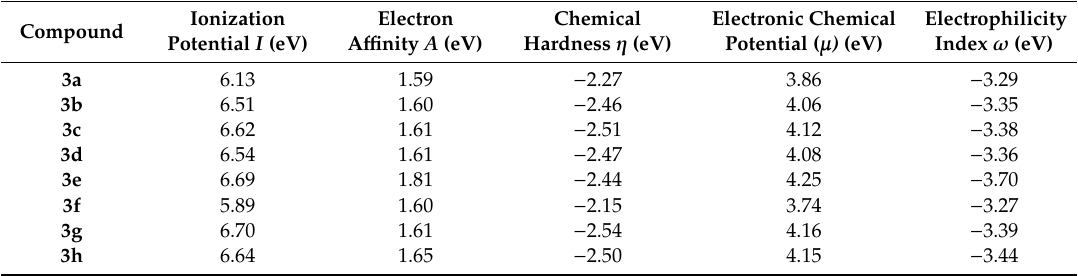
Table 3. Reactivity descriptor’s values of ionization potential (I), electron a ffi nity (A), chemical hardness ( η ), chemical potential ( µ ) and electrophilicity index ( ω ) of compounds ( 3a–3h ) .